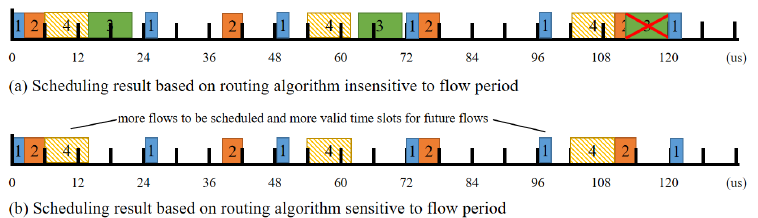
Figure 3. Schedule for three flows on the sw 0 ’s output port. The squares symbolize transmission time slots for the respective flow on the link ( sw 0 4 and sw 2 )